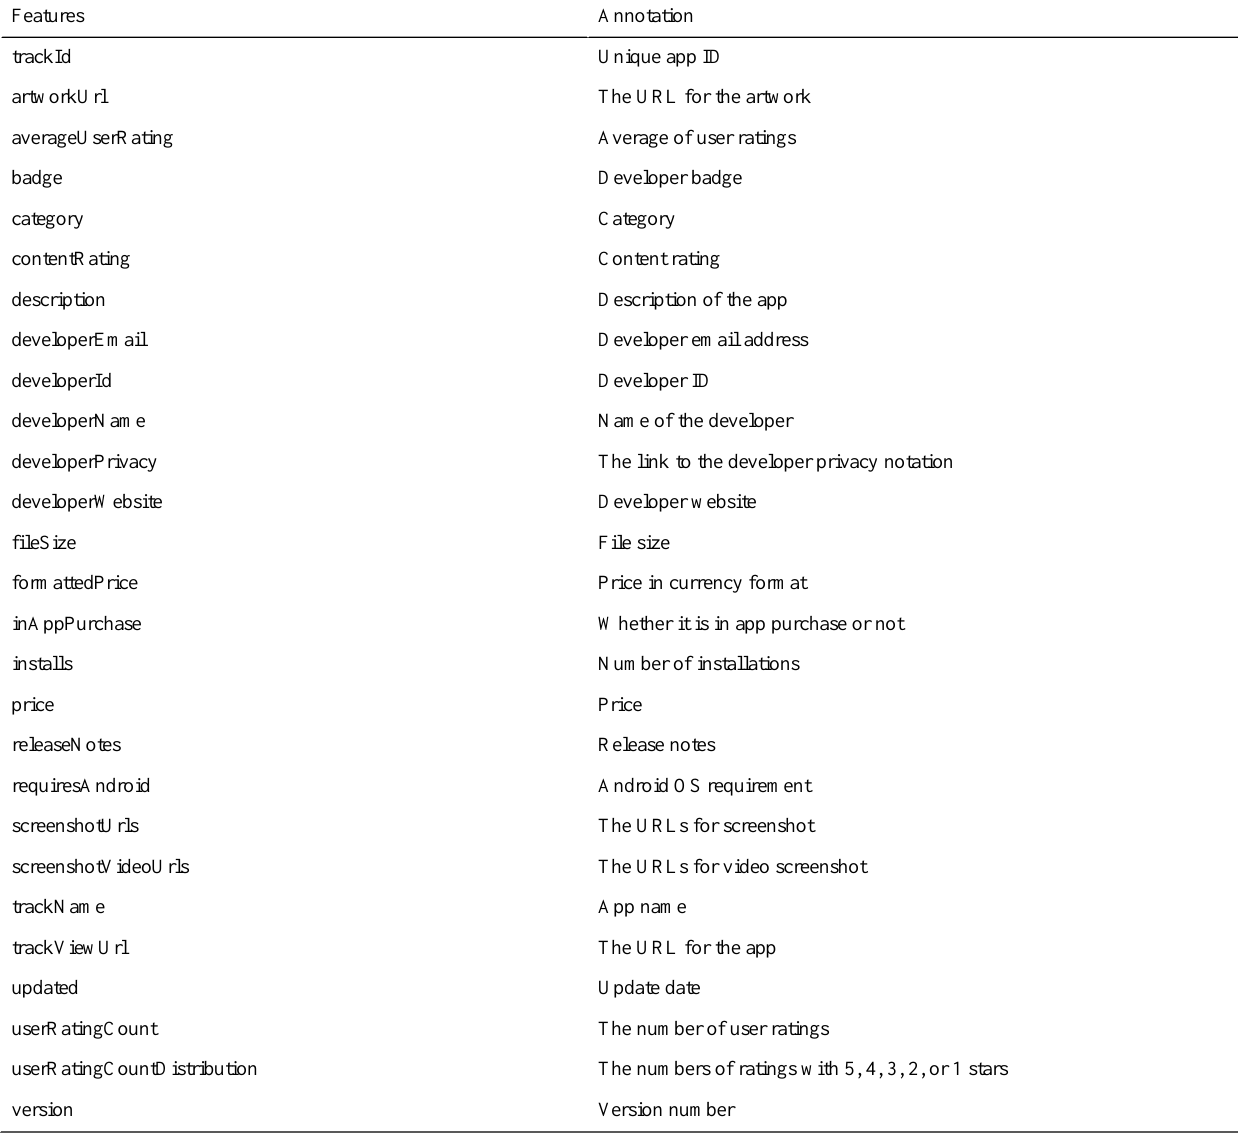
Table 2. The list of 27 features for each app in the GooglePlay.